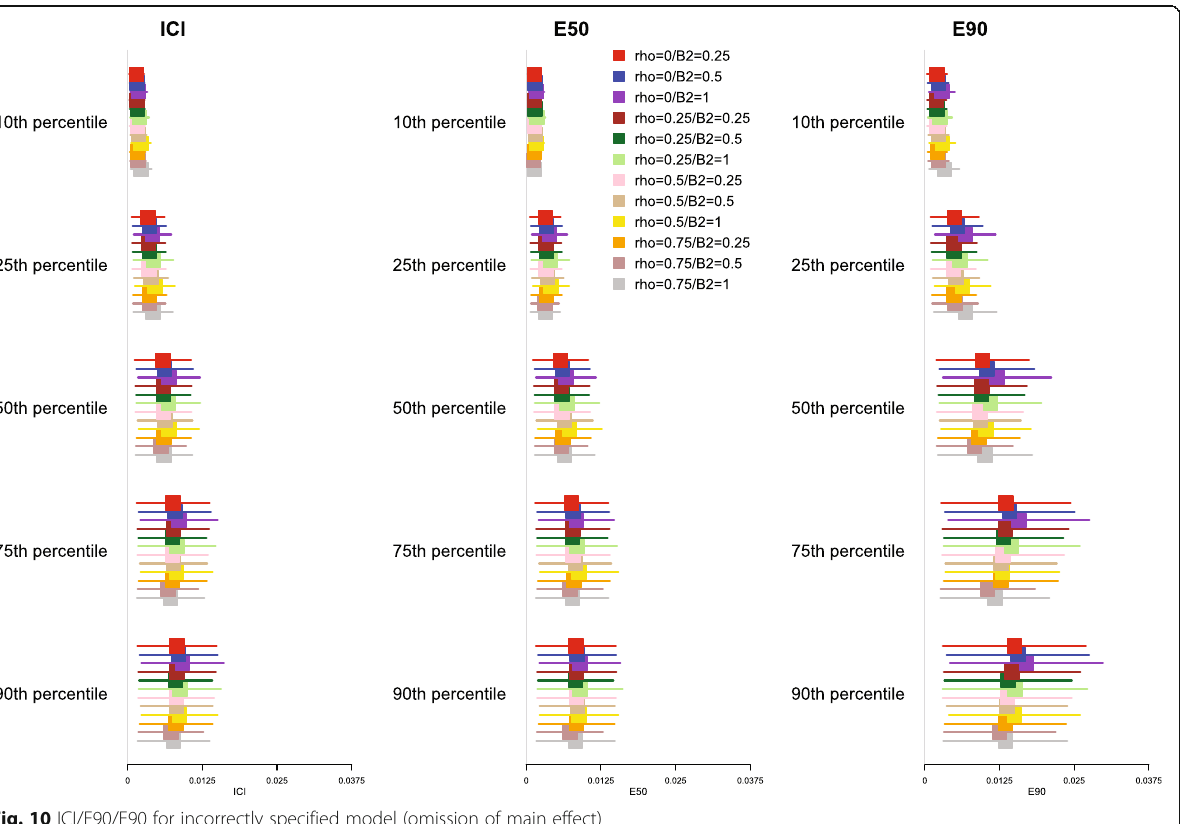
Fig. 10 ICI/E90/E90 for incorrectly specified model (omission of main